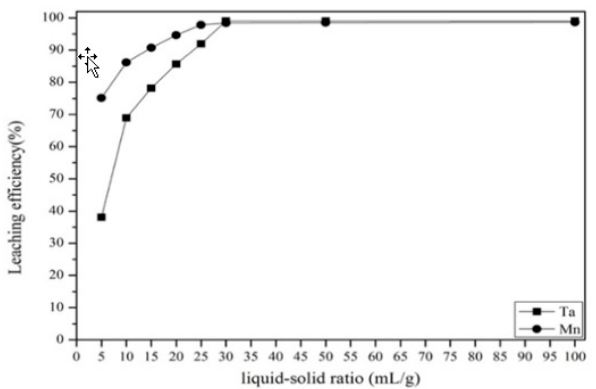
Figure 7. E ff ect of the liquid–solid ratio on the leaching e ffi ciency. Reaction time: 3 h. Concentration: Figure 7. Effect of the liquid–solid ratio on the leaching efficiency. Reaction time: 3 h. Concentration: 5% v / v . Temperature: 180 ◦ 5% v / v . Temperature: 180 °C.